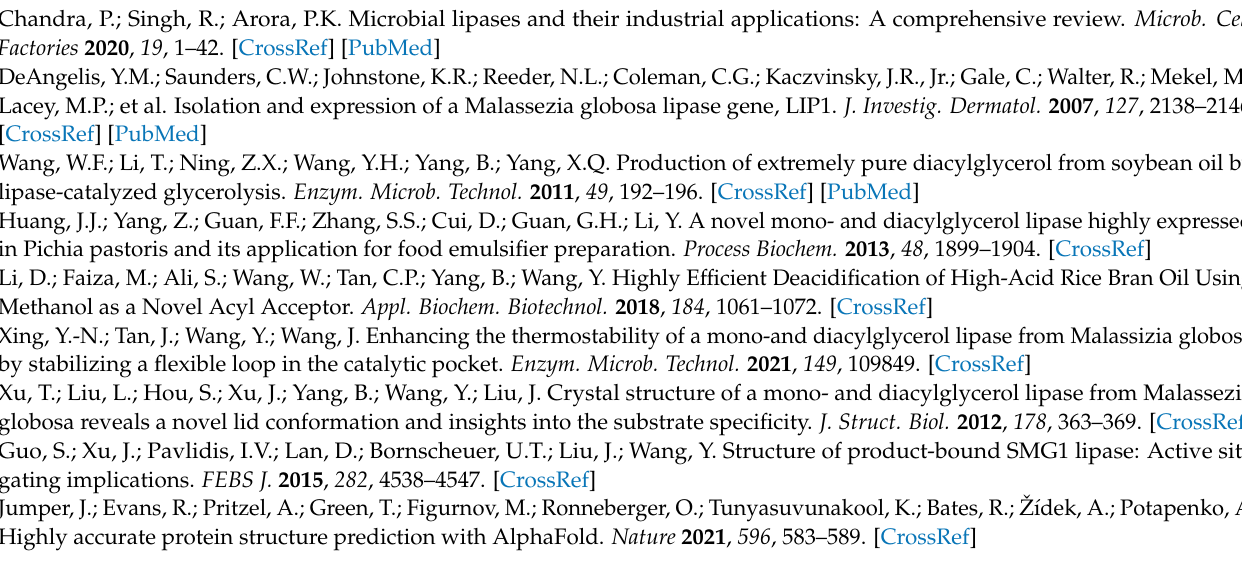
Figure S1. MBP-tag-free SMG1 purification. Figure S2. Melt curve plot for the tag-free SMG1 WT and mutants. Figure S3. Backbone RMSD values of the WT and mutants in the 500 ns MD simulations compared with their respective averaged structures derived from the MD simulation. Figure S4. Conformational changes of residues 291-292 in the MD simulation of the